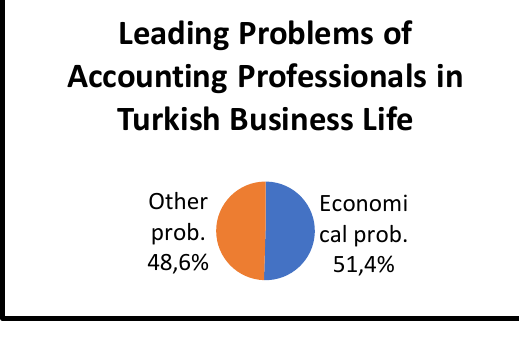
Figure 9. Leading Problems of